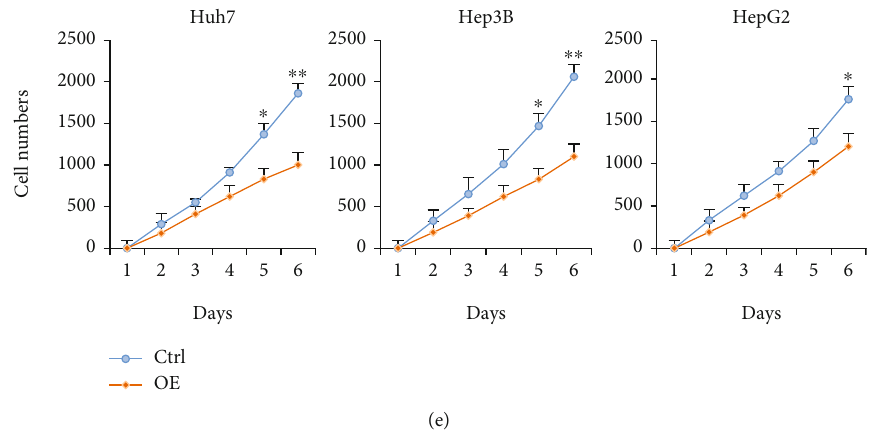
Figure 6: Expression and biological role of miR-497-5p in HCC in vitro . (a) DNA methylation of miR-497-5p in cancer cell lines from the Cancer Cell Line Encyclopedia (CCLE) dataset. (b) DNA methylation of miR-497-5p in 28 liver cancer cell lines from CCLE dataset. (c) Expression levels of miR-497-5p in normal liver cell line LO2 and 4 liver cancer cell lines from GEO dataset GSE71108. (d) qRT-PCR measurement of the levels of miR-497-5p mRNA in Huh7, Hep3B, and HepG2 cells before and after overexpression of miR-497-5p. Data shown are the means ± SD of three independent experiments. (e) Huh7, Hep3B, and HepG2 cell counts in 96-well plate after transfection with negative control or miR-497-5p overexpression plasmids at the indicated day. Statistical analyses were performed with one-way ANOVA ( ∗ p < 0 : 05 , ∗∗ p < 0 : 01 , and ∗∗∗ p < 0 : 001 vs.